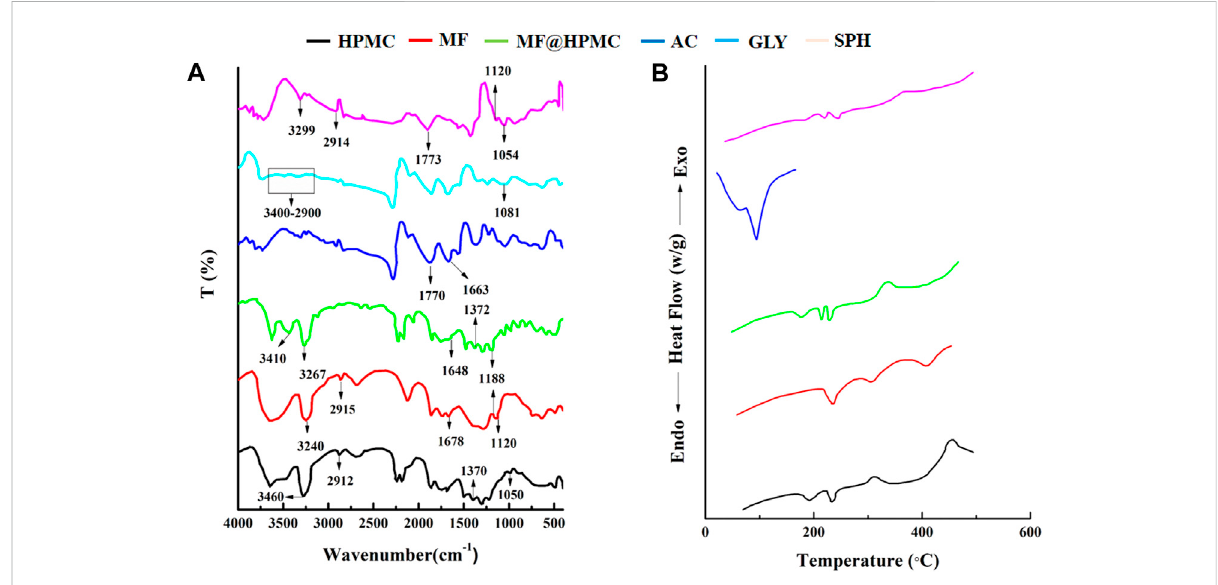
FIGURE 7 FTIR spectra of MF, HPMC, MF@HPMC, AC, GLY, and SPH formulations (A) and DSC thermograms of MF, HPMC, MF@HPMC, AC, GLY, and SPH formulations (B) .